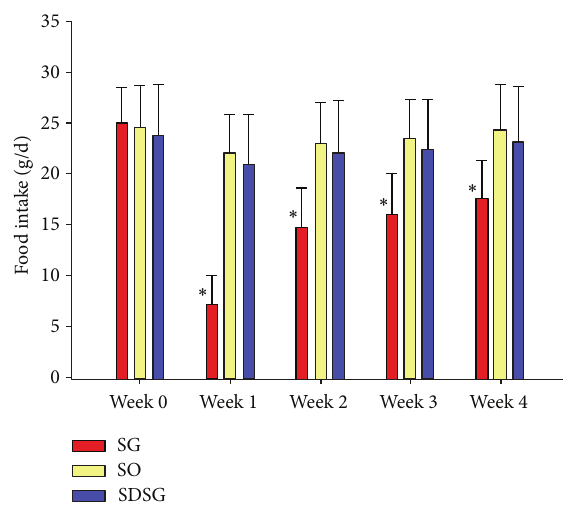
Figure 3: Changes of rat’s food intake amount among sleeve gastrectomy group (SG), sham-operation group (SO), and sleeve gastrectomyofSDratsgroup(SDSG).ComparedwithSOgroupand SDSG group, ∗ 𝑃 < 0.05 .